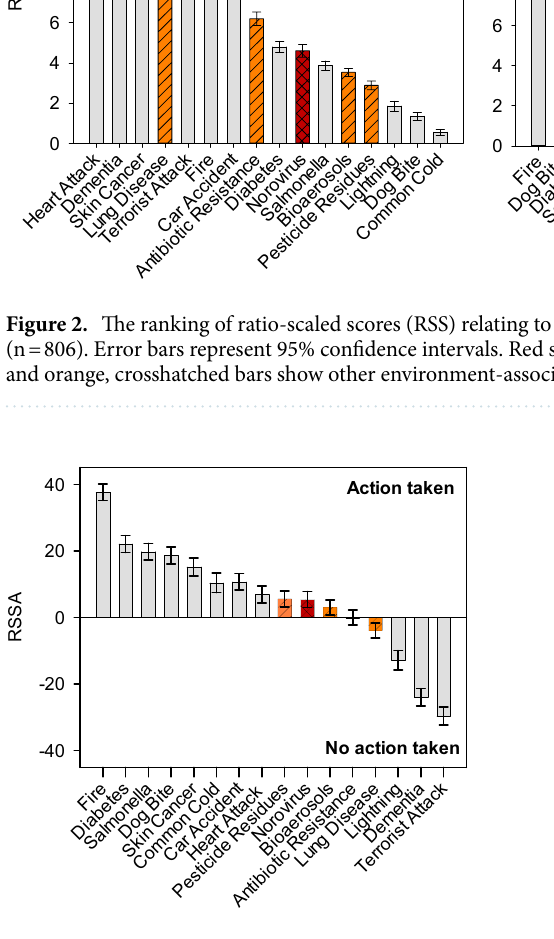
Figure 3. Anchored ratio-scaled control scores (RSSA). Zero = threshold for taking action to reduce the risk. The error bars represent 95% confidence intervals. Red striped bar shows risk associated with norovirus and orange, crosshatched bars show other environment-associated